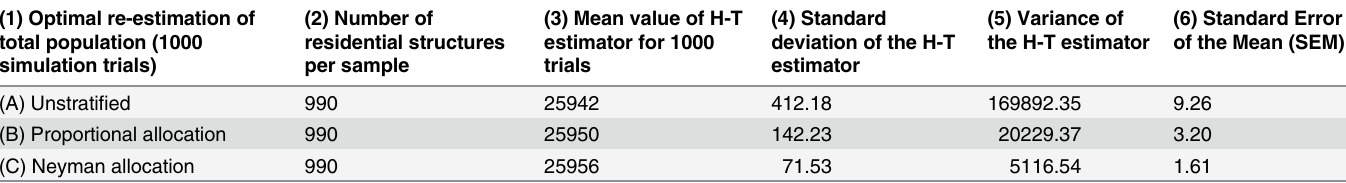
Table 5. A comparison of uncertainty for unstratified, proportional-, and Neyman-allocated population